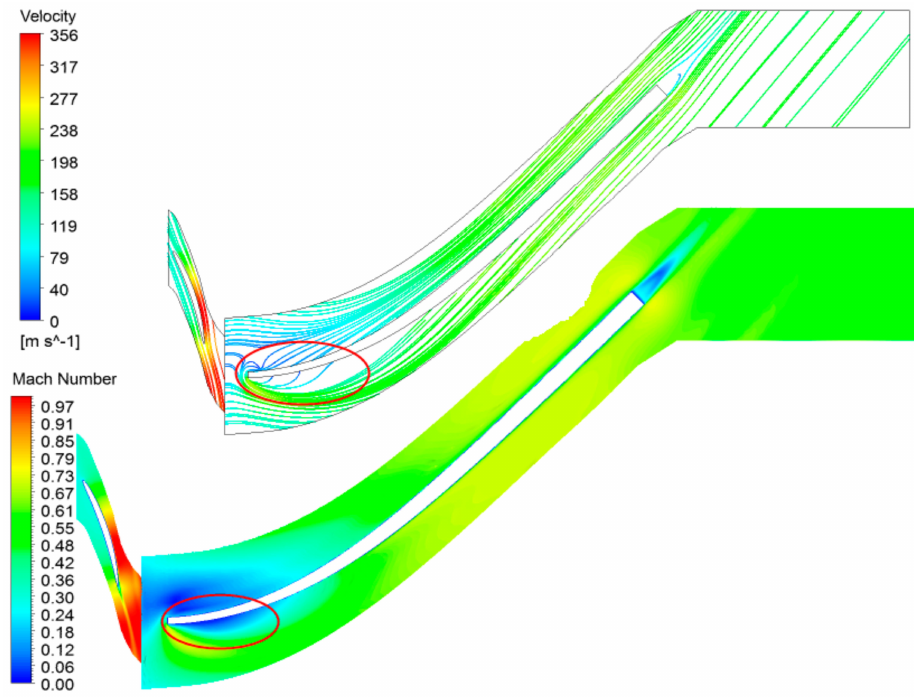
Figure 19. The streamline and Mach number contour at mid span for design point conditions.